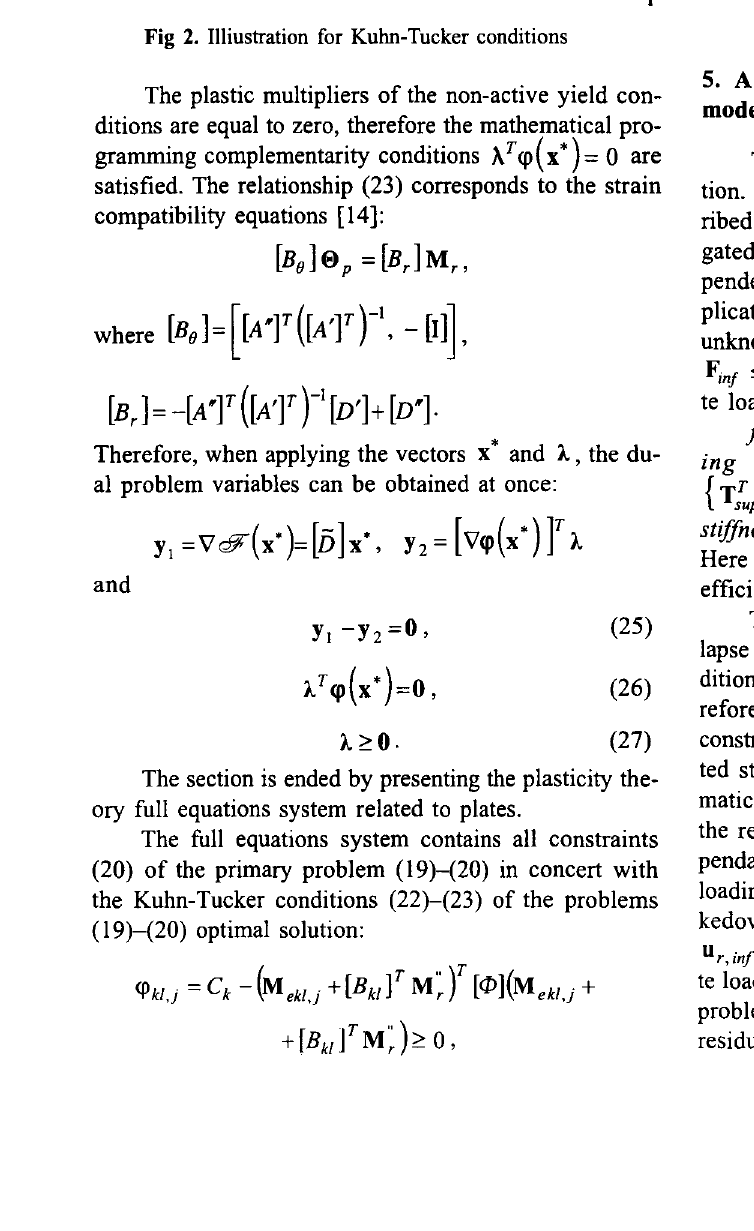
Fig 2. Illiustration for Kuhn-Tucker